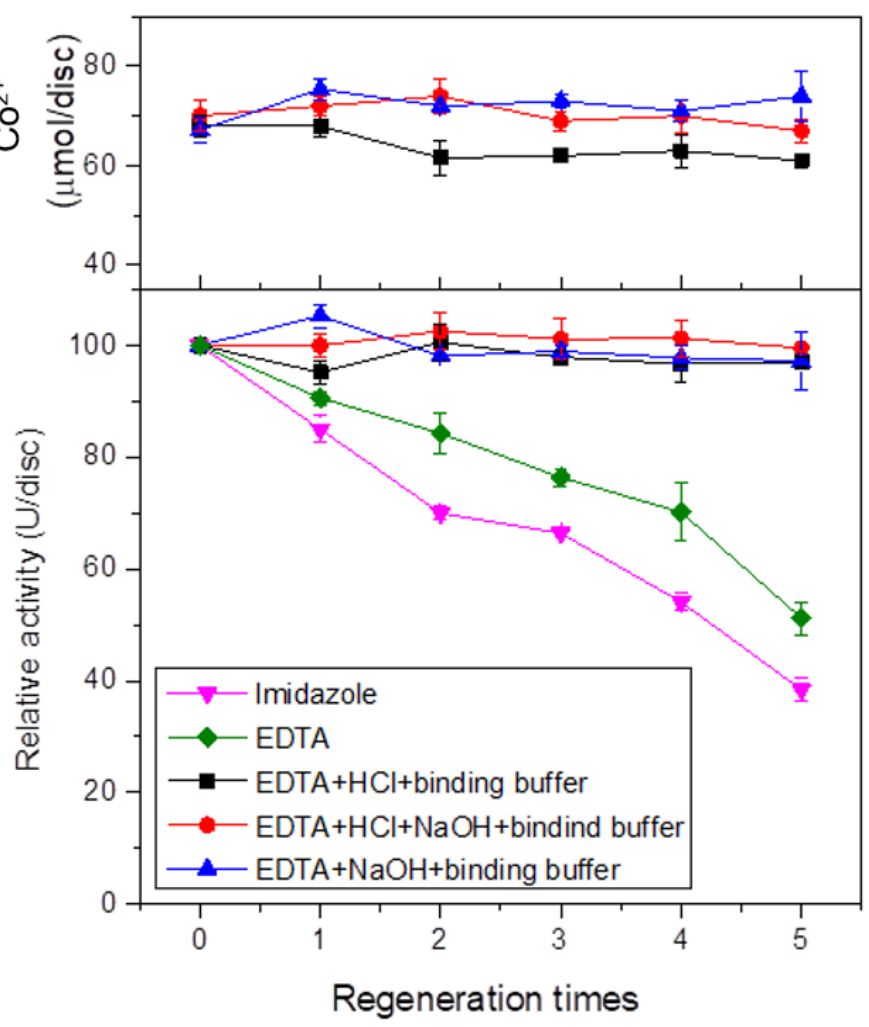
Figure 11. Impact of various stripping solutions on IMAM regeneration. The combination of HCl or/and NaOH with EDTA sequentially in binding buffer as a stripping solution resulted in almost the same levels of metal ion and protein adsorption in the regenerated membrane (Figure 11). In addition, the adsorbed CelA endoglucanase activity after each regeneration process was almost similar to the original activity. This indicated that the proposed regeneration methods, by the addition of either HCl or NaOH, can effectively remove the impurity contaminants on the surface of IMAMs to regenerate a new IMAM for effective CelA coupling. This is the first report on developing and using reversible IMAMs as a matrix for recombinant endoglucanase